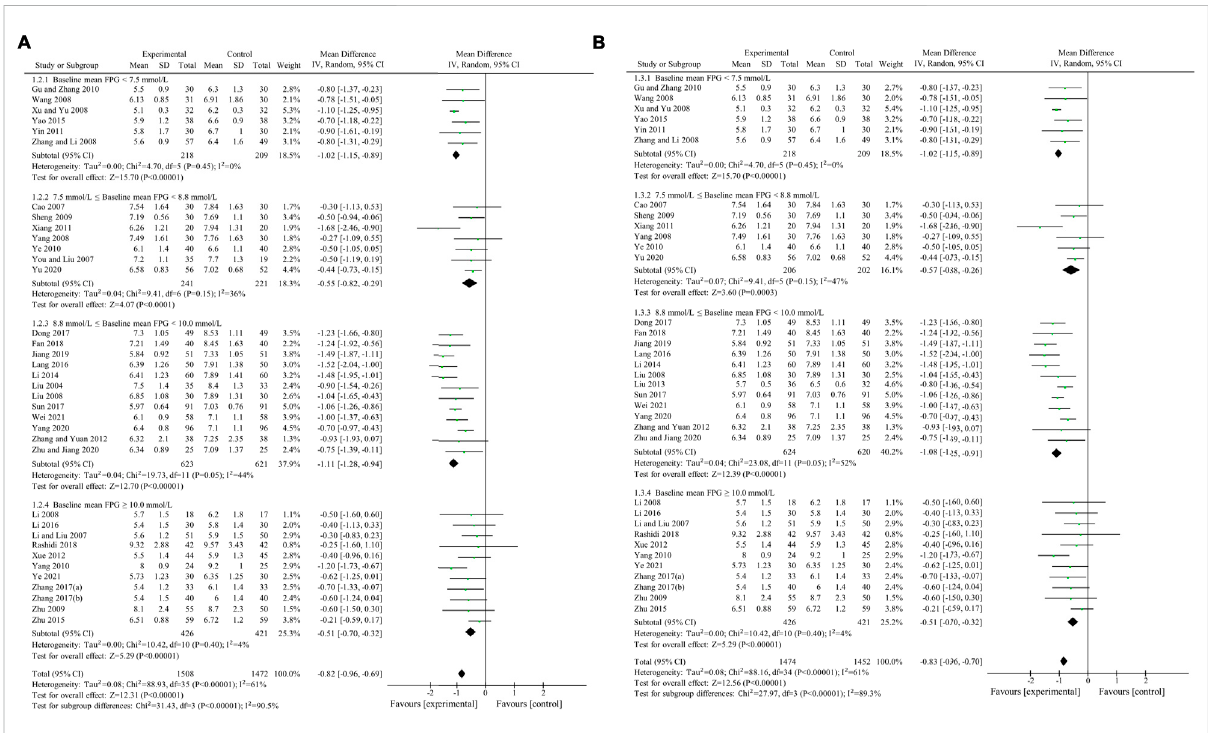
FIGURE 4 Sensitivity analyses by exclusion of apparently poor quality reports and exclusion of studies with too short treatment duration ( ≤ 3w). (A) Sensitivity analysis by exclusion of apparently poor quality reports (B) Sensitivity analysis by exclusion of studies with too short treatment duration ( ≤ 3w).